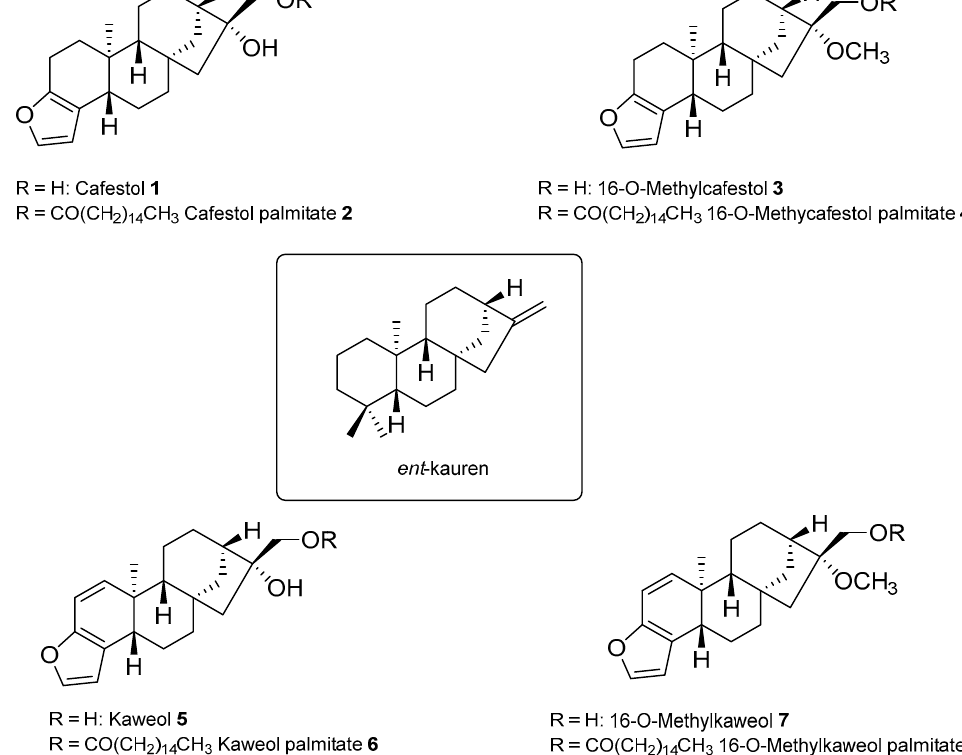
Figure 1. Structure of diterpenes and diterpene palmitates